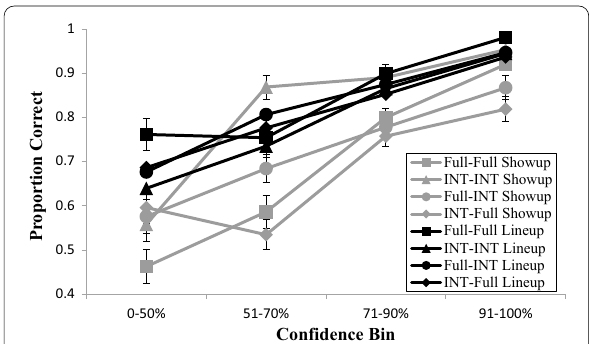
Fig. 10 CAC curves for all conditions, with standard error